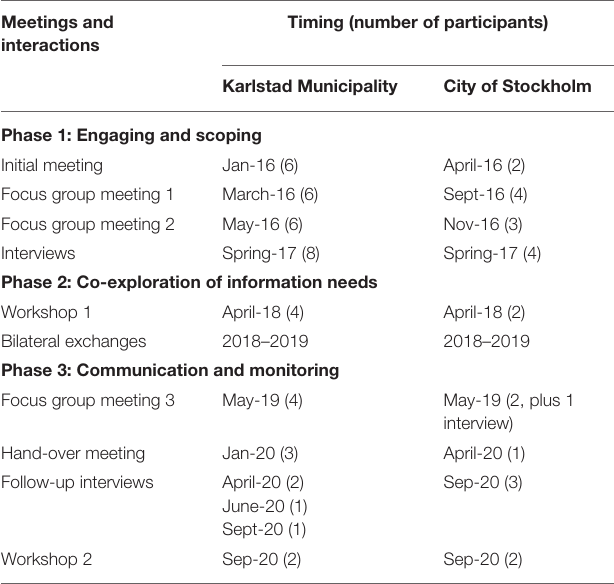
TABLE 1 | Overview timing of meetings and number of